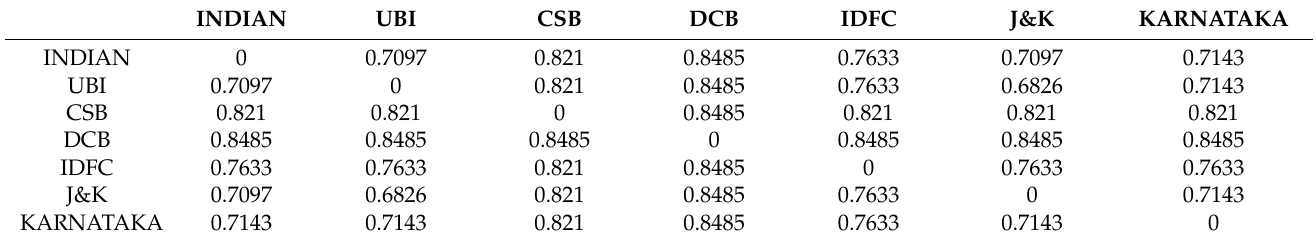
Table 15. Adjacency matrix of the strength of connectedness (last component): reduced list of 7 banks.